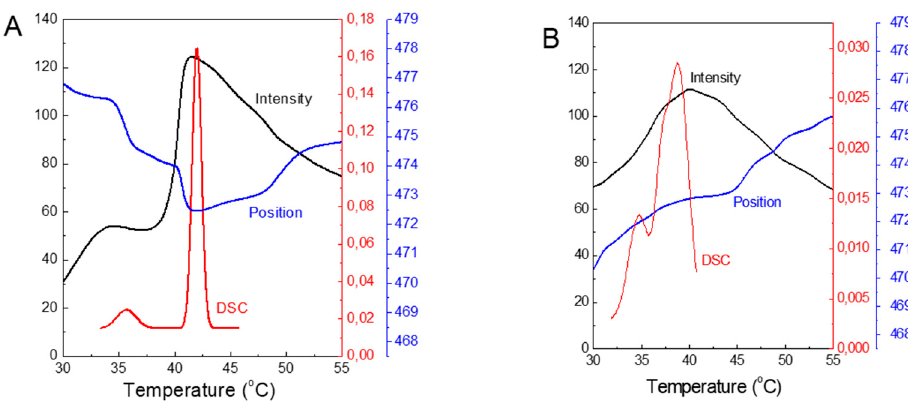
Figure 8. Summary plot of the ANS FI max - Intensity (a.u.) and their λ max - Position (nm) and the DSC trace of DPPC ( µ W) versus temperature observed during the heating of the samples: for pure DPPC ( A ) and for DPPC with 10 mol% of TS ( B ).